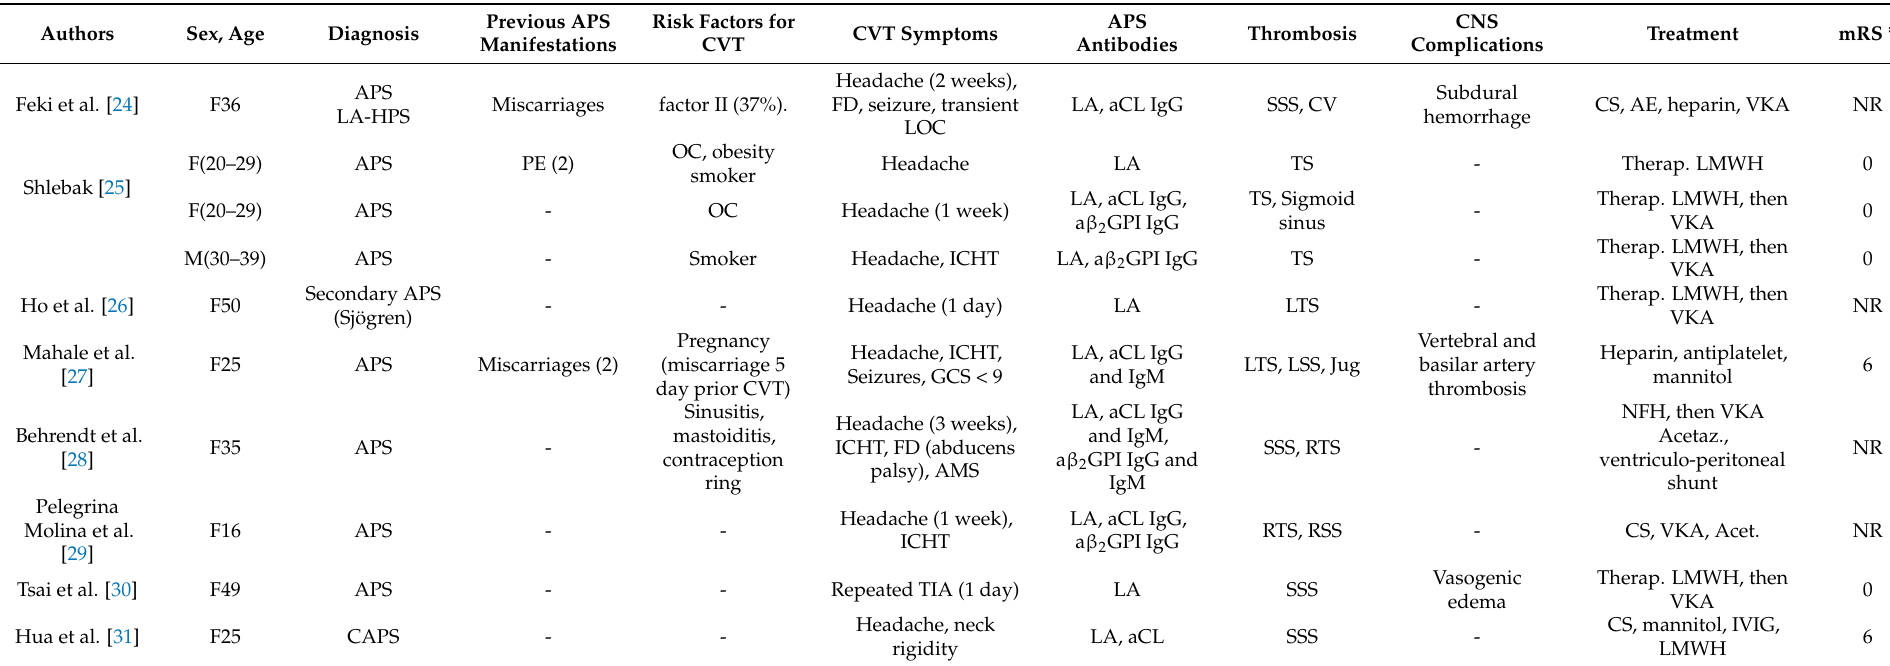
Table 5. Cases of patients with CVT and APS published in the literature: clinical characteristics and outcome. * mRS at hospital discharge. Abbreviations: F, female; M, male; APS, antiphospholipid syndrome; SLE, systemic lupus erythematosus; ET, essential thrombocytosis; SSc, systemic sclerosis; LA-HPS, Lupus anticoagulant-hypoprothrombinemia syndrome; CON, cryptogenic organising pneumopathy; UCTD, undifferentiated connective tissue disease; DVT, deep vein thrombosis; UL, upper limbs; LL, lower limbs; PE, pulmonary embolism; Thrombocytop, thrombocytopenia; LP, lumbar puncture; OC, oral contraceptives; PC deficit, protein C deficit; CS, corticosteroids; PS deficit, protein S deficit; HH, hyperhomocysteinemia; Leiden (het), heterozygous factor V Leiden mutation; Leiden (hom), homozygous factor V Leiden mutation; LOC, loss of consciousness; FD, focal deficit; ICHT, intracranial hypertension; AMS, altered mental status; GCS, Glasgow Coma Scale; LA, lupus anticoagulant; aCL, anticardiolipin antibodies; a β 2 GPI, anti- β 2 -glycoprotein-I antibodies; RTS, right transverse sinus; LTS, left transverse sinus; TS, transverse sinus; SSS, superior sagittal sinus; SS, straight sinus; RSS, right sigmoid sinus; LSS, left sigmoid sinus; Jug, jugular vein; CV, cortical veins; VI, venous infarction; PB, parenchymal bleeding; SAH, subarachnoid hemorrhage; VKA, vitamin K antagonists; IVIG, intravenous immunoglobulins; AE, antiepileptic treatment;